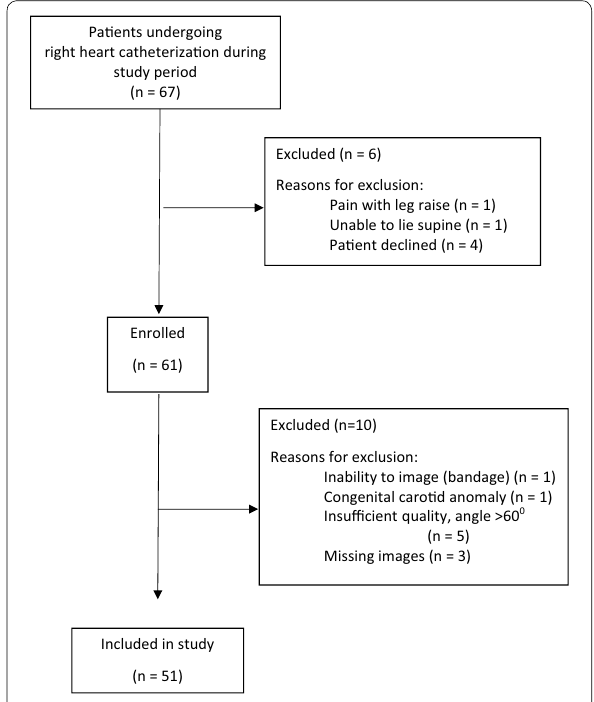
Fig. 2 Flow chart of number of patients enrolled in the study and included in the